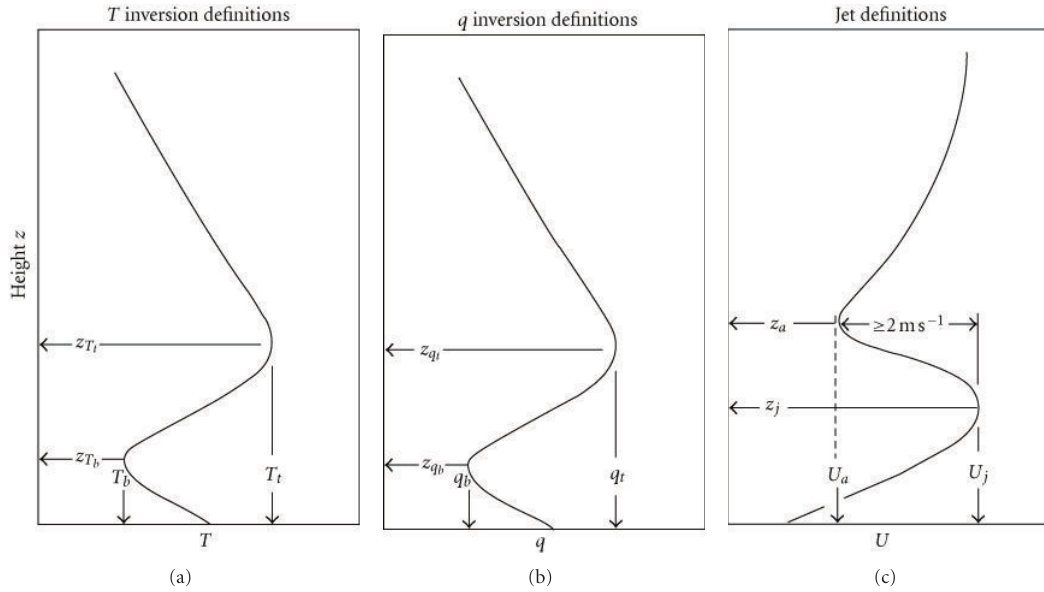
Figure 4: (a) Parameters of a temperature T inversion: z Tb is the height of the temperature inversion base, z Tt the temperature inversion top height, T b the temperature at the inversion base, and T t the temperature at the inversion top; (b) Parameters of a humidity inversion: z qb is the height of the humidity inversion base, z qt the humidity inversion top height, q b the specific humidity at the inversion base, and q t the specific humidity at the inversion top. (c) Parameters of a low-level jet. z j is the height of the jet core and U j the wind speed of the jet core. U z a is the height of the wind minimum above the jet core and a the wind speed there. Modified from Andreas et al.